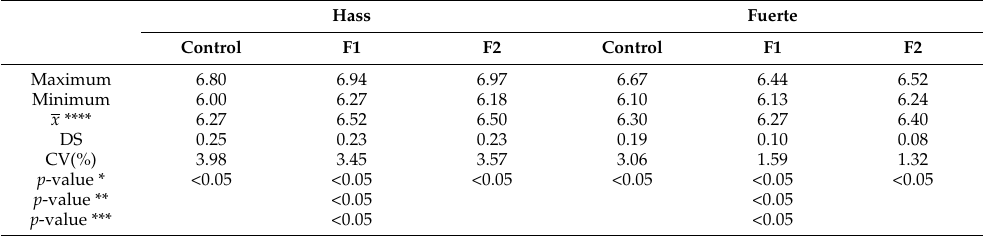
Figure 4. pH variation ( a ) Hass variety, ( b ) with respect to the addition of starch—Hass variety, ( c ) Fuerte variety, ( d ) with respect to the addition of starch—Fuerte variety. Table 4. pH of control and coated avocado.